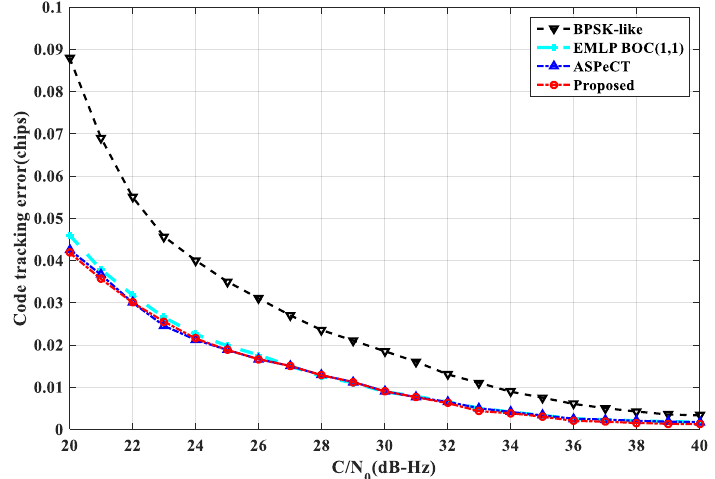
Figure 23. Code tracking error standard deviation of BOC(1,1).